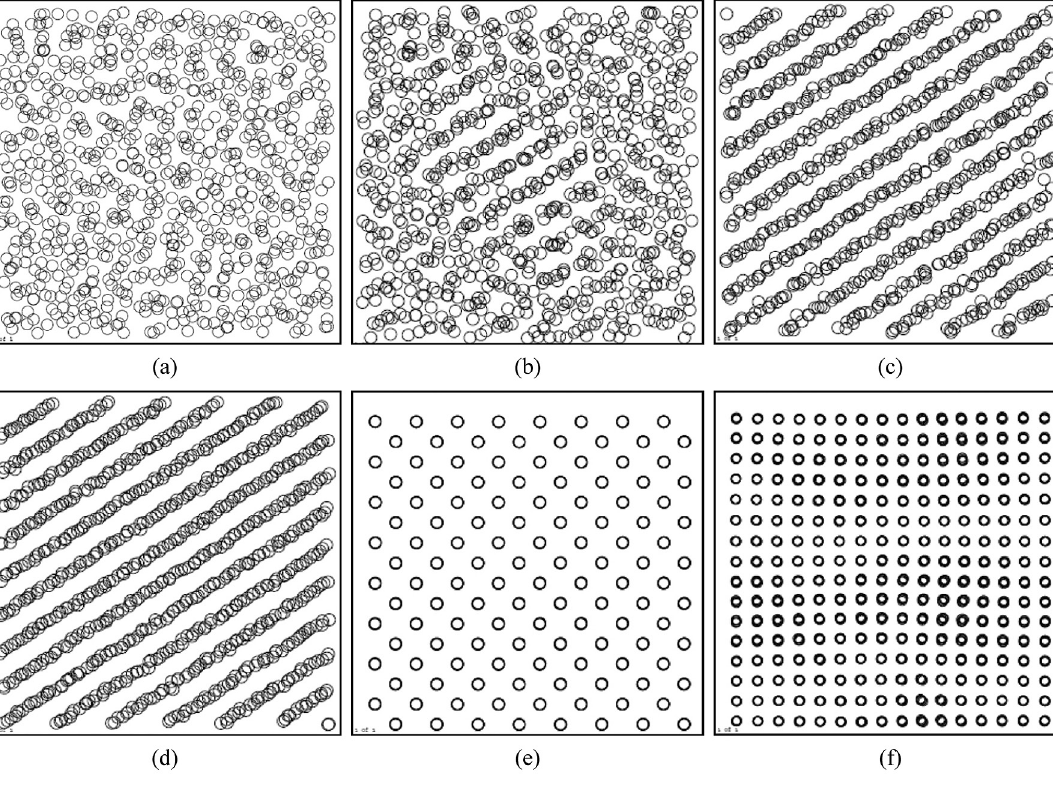
Figure 3. Two-dimensional cross-sectional projections of the structures of Fe obtained under different pressures at cooling rate of 4 × 1012 K/s. (a) 4GPa, 300K; (b) 1.4GPa, 1100K; (c) 1.4GPa, 900K; (d) 1.4GPa, 300K; (e) bcc structure; (f) fcc